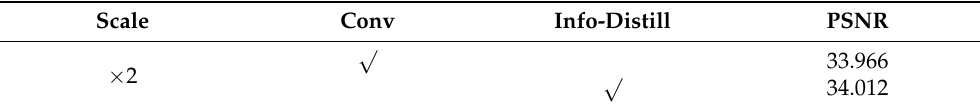
Table 1. The effectiveness of information distillation of the model. We compared the traditional convolution and information distillation after 2 × 10 5 iterations on the validation set for ×2 scale SR.